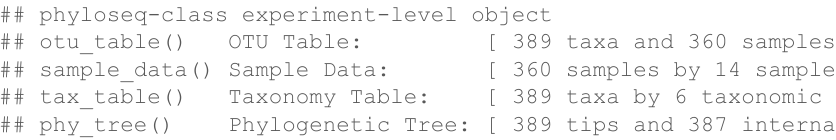
Phylogenetic Tree: [ 389 tips and 387 internal nodes